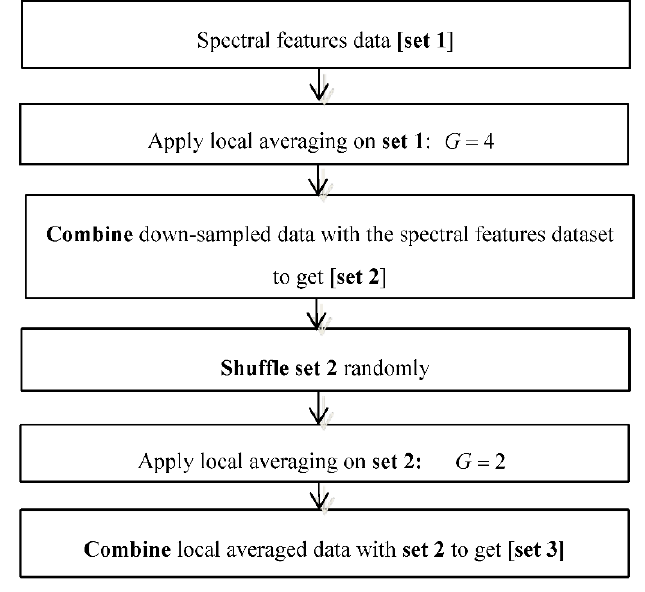
Figure 5. Data augmentation workflow.